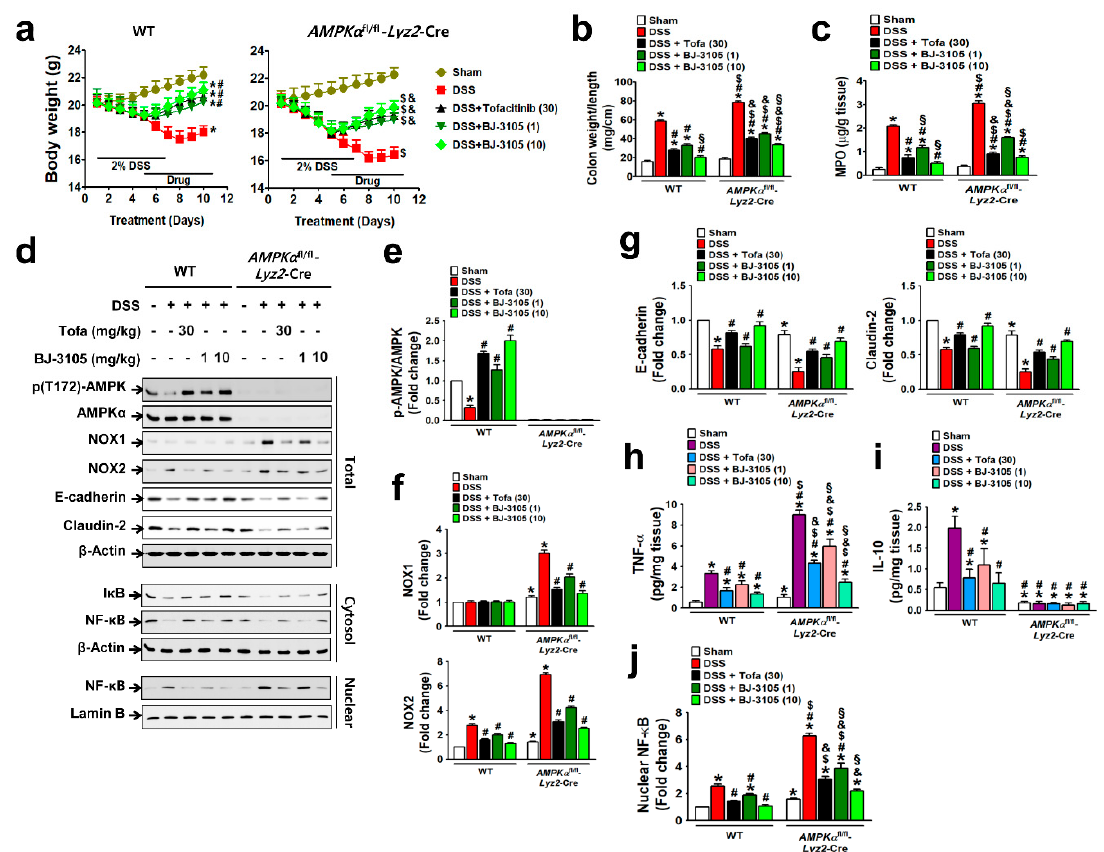
Figure 6 . BJ-3105 was more effective than tofacitinib at ameliorating DSS-induced colitis in mice. (a-c) Inhibitory effects of tofacitinib and BJ-3105 on DSS-induced colitis in WT and AMPK α fl/fl -Lyz2 -Cre mice were evaluated by measuring body weights ( a ), colon weight/unit length ( b ), and MPO level in colon tissues (c). ( d–g ) The effects of tofacitinib and BJ-3105 on gene expression levels in total protein, cytosolic, and nuclear extracts of colon tissues were determined by immunoblotting (d). Densitometry was used to assess p-AMPK/AMPK (e), NOX1/2 (f), and epithelial junction molecules, and E-cadherin and claudin-2 levels (g). (h,i) TNF- α ( h ) and IL-10 ( i ) levels in colon tissues were determined by ELISA. ( j ) Densitometry results of nuclear levels of NF- κ B ( j ). * p < 0.05, versus sham-operated WT controls. # p < 0.05, versus DSS-treated WT mice. $ p < 0.05, versus sham-operated AMPK α fl / fl - Lyz2 -Cre mice. & p < 0.05, versus DSS-treated AMPK α fl / fl - Lyz2 -Cre mice. § p < 0.05, versus tofacitinib-treated WT or AMPK α KO mice.